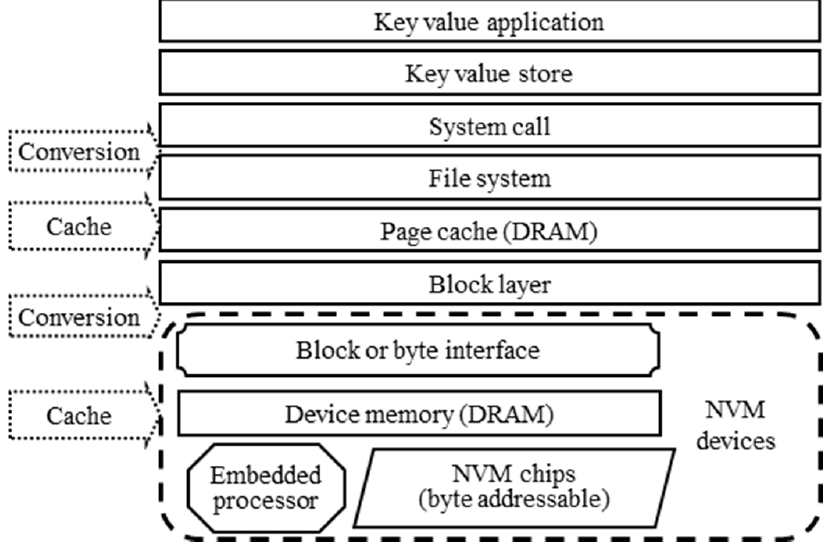
Figure 1. The structure of key–value store for the NVM devices.